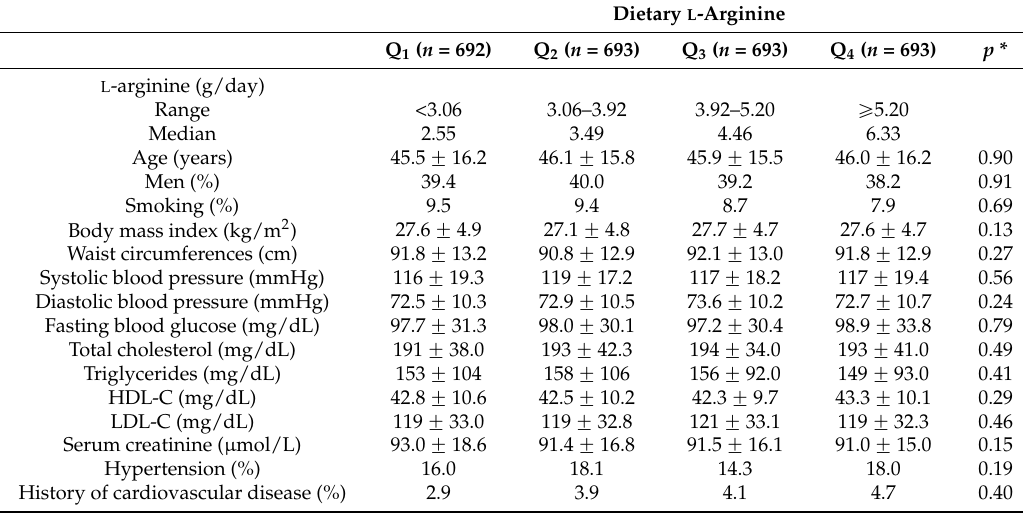
Dietary L -Arginine